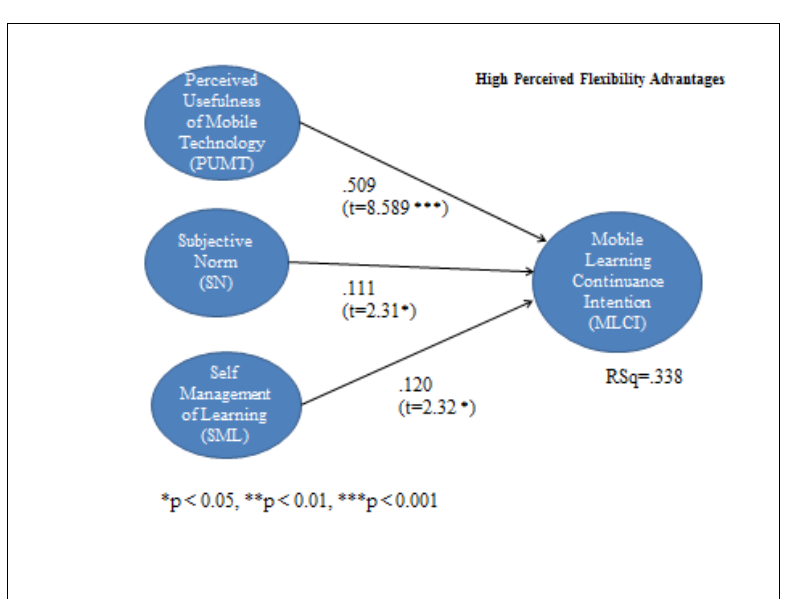
Figure 3. PLS solution for high perceived flexibility advantages group.